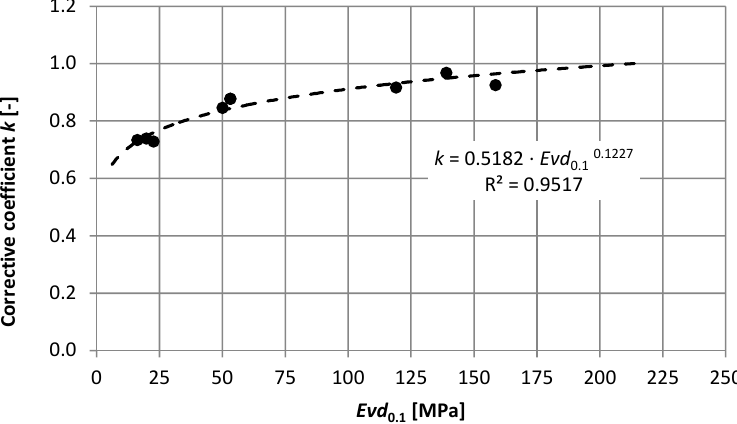
Figure 8. Correction factor for dynamic moduli determined in the test with a plate load of 0.1 MPa.